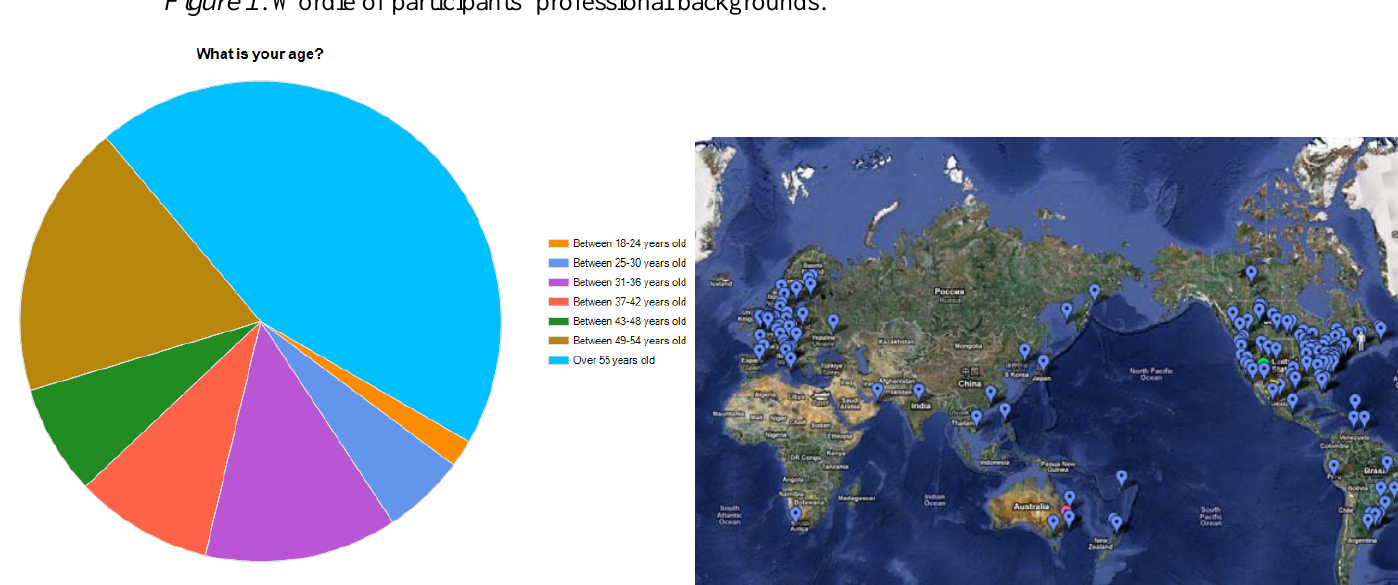
Chart 1 . PLENK participants’ ages. Figure 2 . PLENK participants’ places of